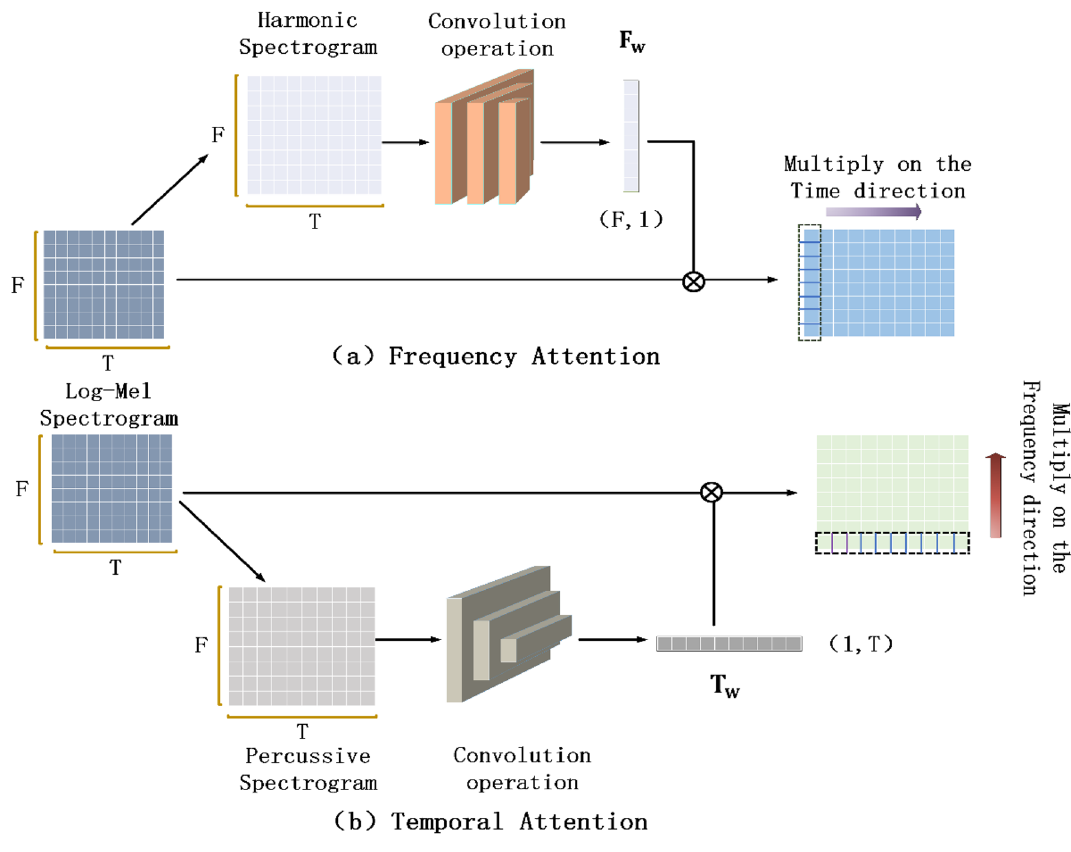
Figure 5. The generation process of two attention